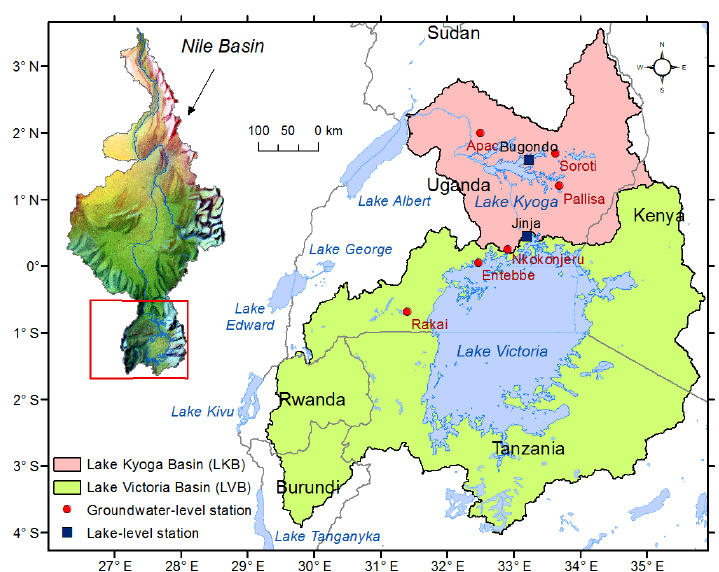
Figure 1. Map of the study area encompassing the Lake Victoria Basin (LVB) and Lake Kyoga Basin (LKB), and location of the in situ monitoring stations. The Upper Nile Basin is marked by a rectangle (red) within the entire Nile River Basin shown as a shaded relief index map. Piezometric monitoring (red circles) and lake-level gauging (dark blue squares) stations are shown on the map.